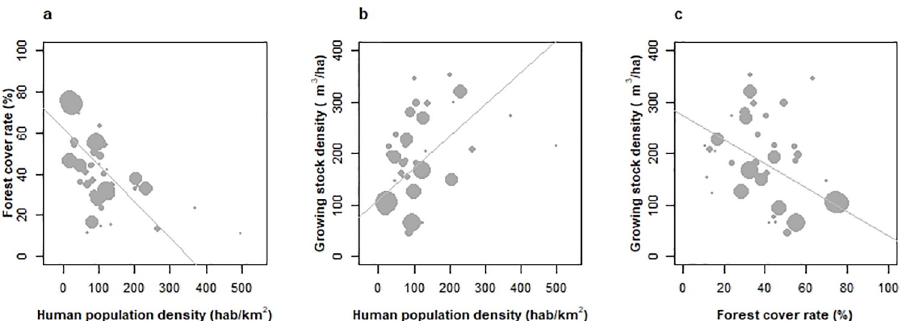
Fig 1. Relationships between human population density and forest area and growing stock across 39 most forested European countries. Correlations weighted by forest area in 2015 are figured. (a) Forest cover ( fraction of total country area occupied by forests) in 2015 demonstrates a strong negative relationship with population density (weighted correlation -0.64, p < 10 − 4 ), (b) a strong relationship of opposed sign is found with the growing stock density (weighted correlation +0.54, p < 10 − 3 ) indicating that growing stock capitalisation has been stronger in countries with smallest forest areas, (c) A trade-off between forest cover and growing stock is accordingly evidenced (weighted correlation -0.56, p < 10 − 3